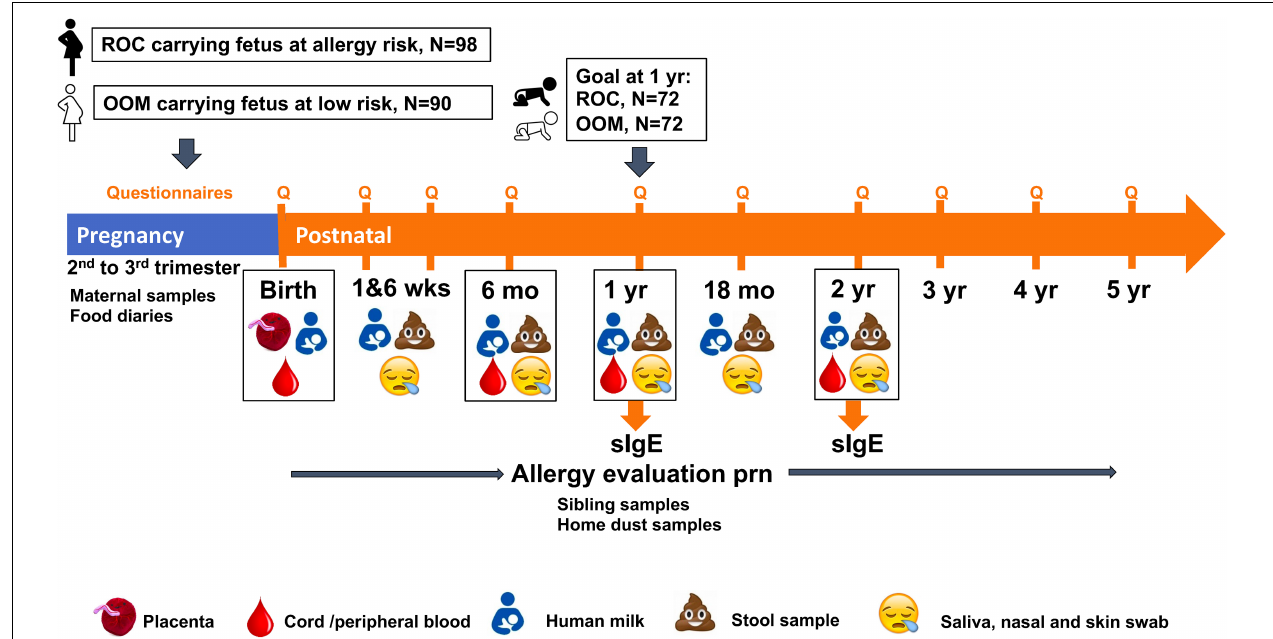
FIGURE 1 | Overall study schematic. Pregnant Old Order Mennonite (OOM) and Rochester women carrying fetuses at risk for allergic disease were enrolled prenatally to a longitudinal birth cohort of infants to assess development of microbiome, systemic and mucosal immune system as well as allergic diseases. Visit and sample collection time points are shown. Specific IgE to select food and aeroallergens are measured at 1 and 2 years of age. Allergy evaluation is performed as indicated by any allergic symptoms throughout the follow up.